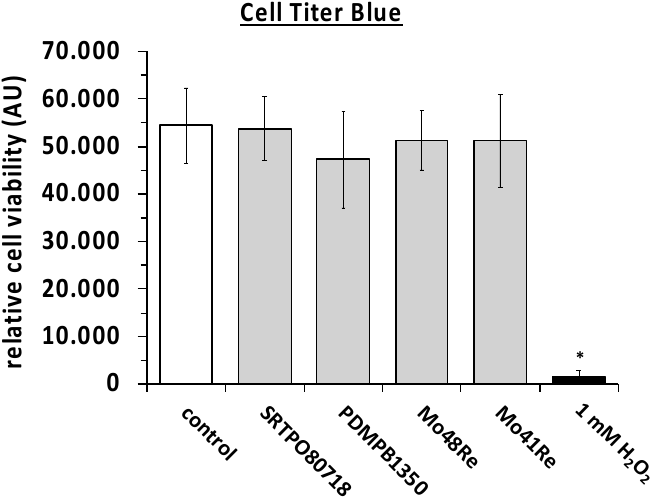
Figure 1. ( A ) Vitality of human skin fibroblasts and osteoblasts seeded on a molybdenum crucible in comparison to a Petri dish (control). ( B ) Positive fluorescein diacetate (FDA) staining of living adherent osteoblasts on the molybdenum crucible. ( C ) Representation of the size of the molybdenum crucible used.